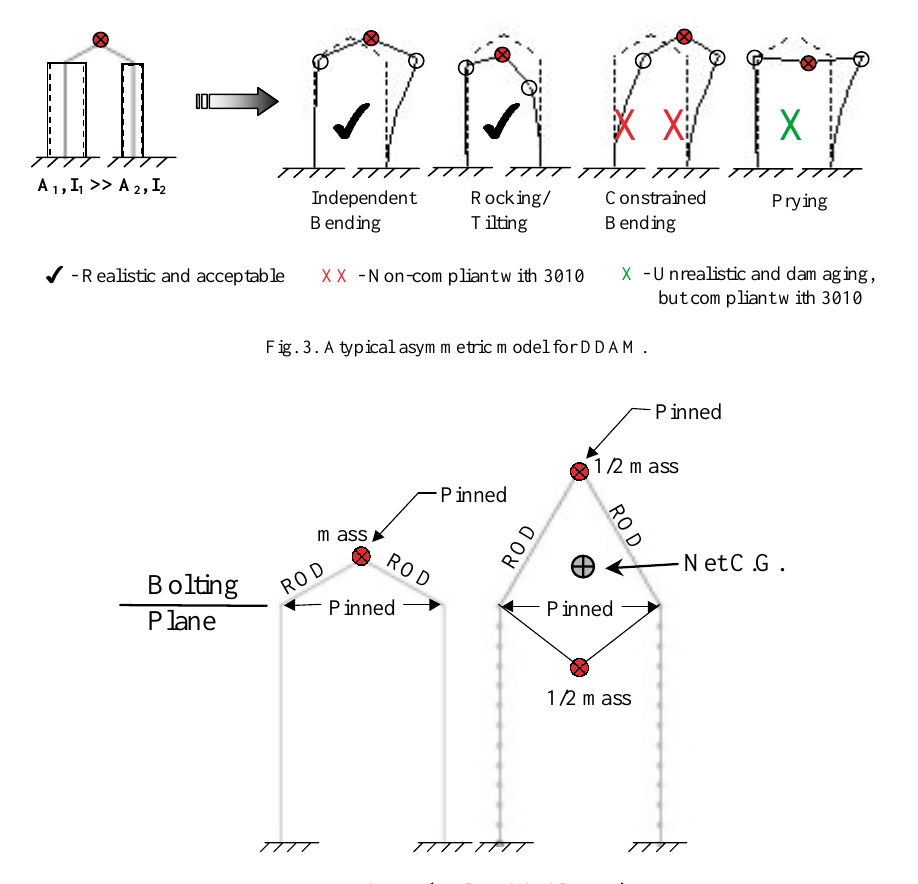
Fig. 4. Rod cases (single and double